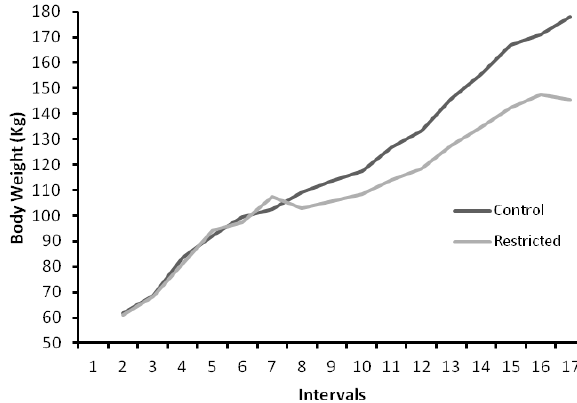
Figure 1. Body weight changes in calves at approximately 10 d